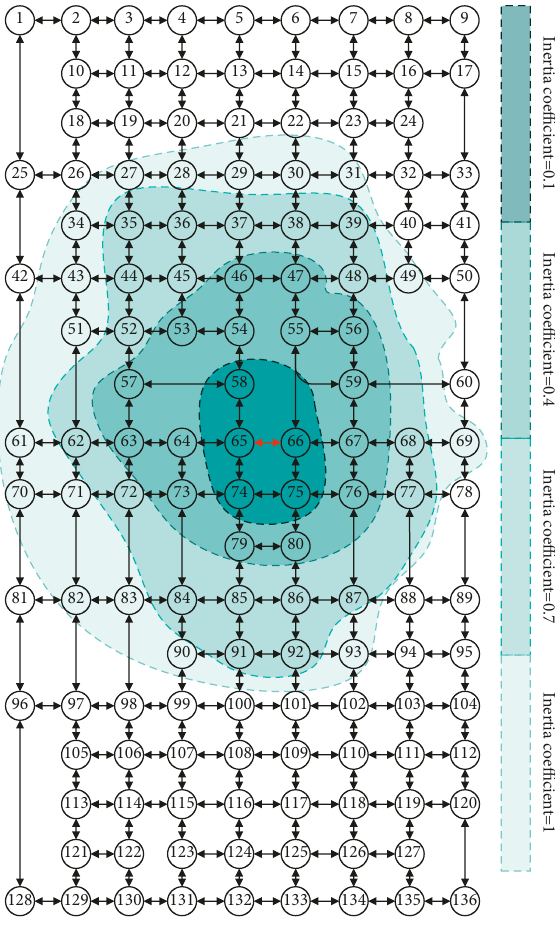
Figure 13: Subnetwork under different elasticity. Figure 12: Subnetwork under different